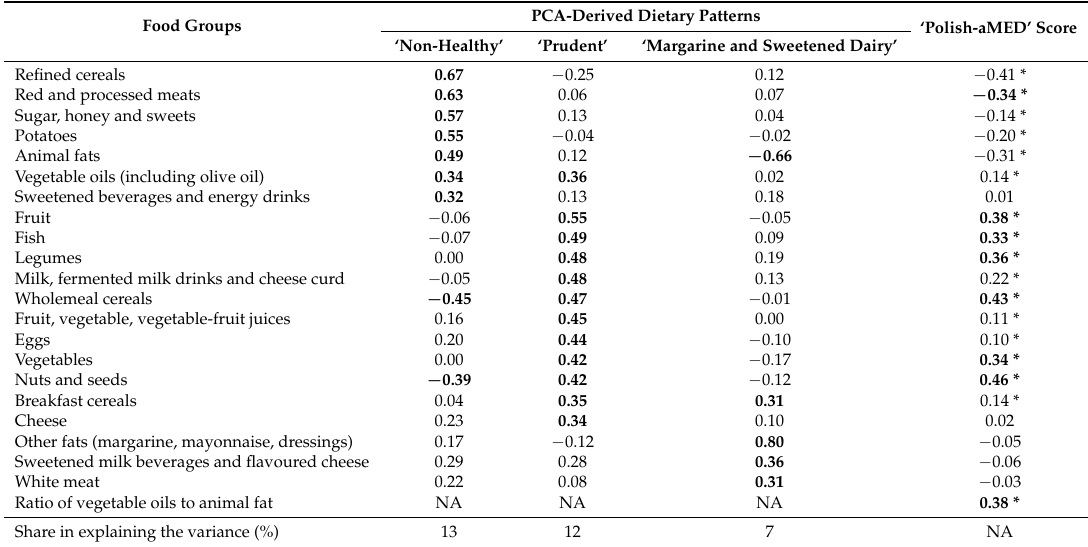
Table 3. Factor loadings for food groups in PCA-derived dietary patterns and the Pearson’s correlation coefficients for ‘Polish-aMED’ score among peri- and post-menopausal women ( n = 420). Food Groups PCA-Derived Dietary Patterns ‘Polish-aMED’ Score ‘Non-Healthy’ ‘Prudent’ ‘Margarine and Sweetened